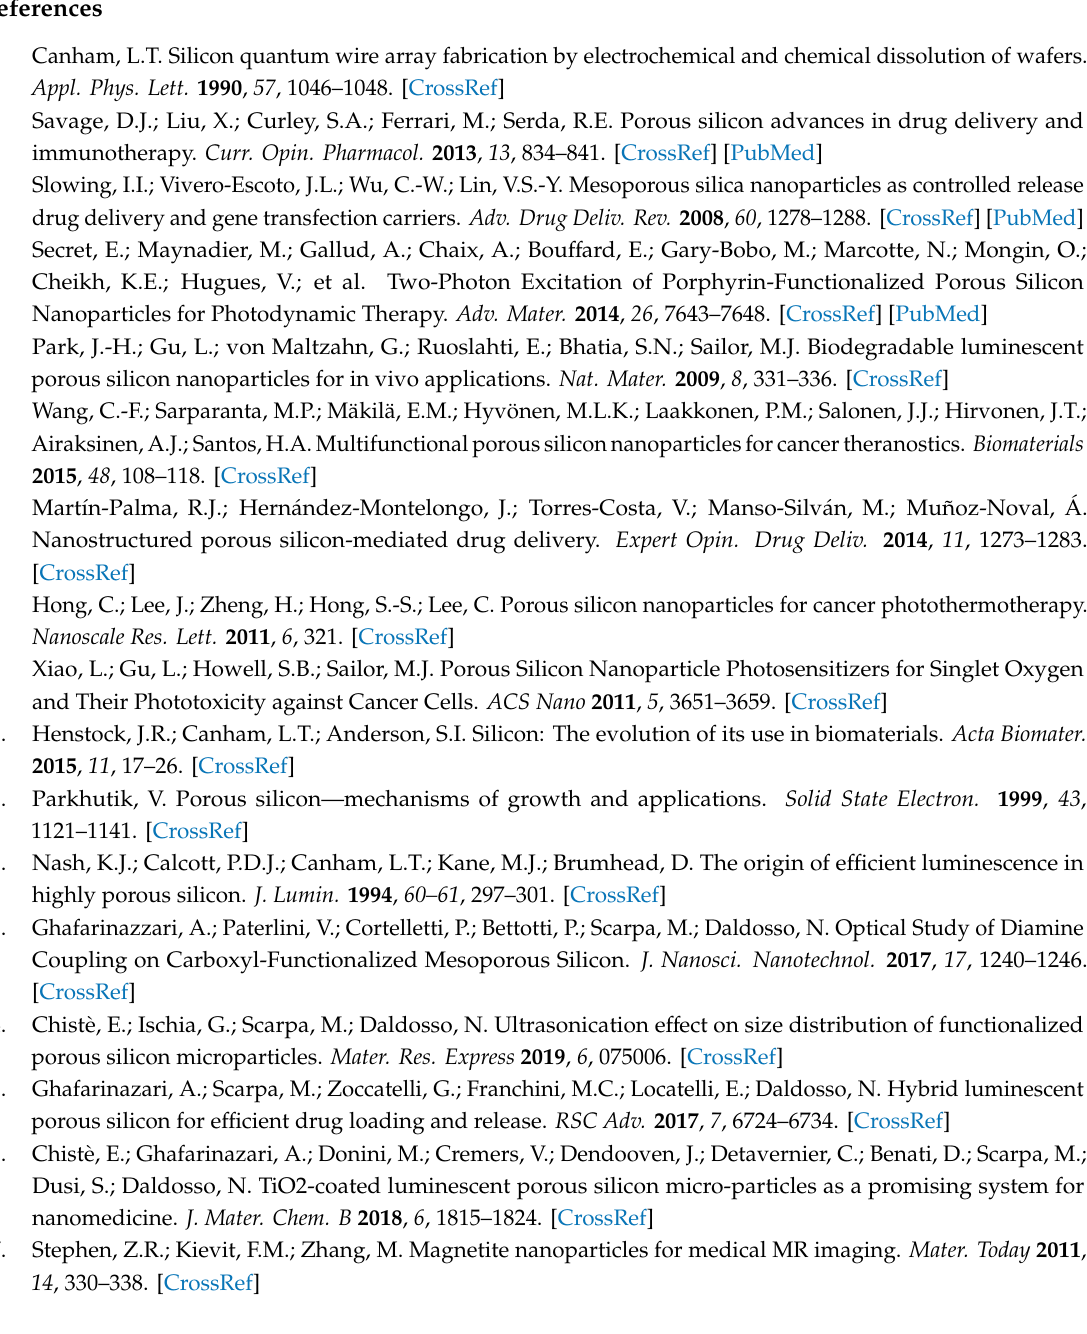
Figure S1: Functionalized porous Si microparticles infiltration scheme; Figure S2: HR-TEM image and di ff raction pattern of a SPION nanoparticle; Figure S3: ζ -potential distribution of functionalized SPIONs; Figure S4: EDS spectrum of pSi-SPIONs